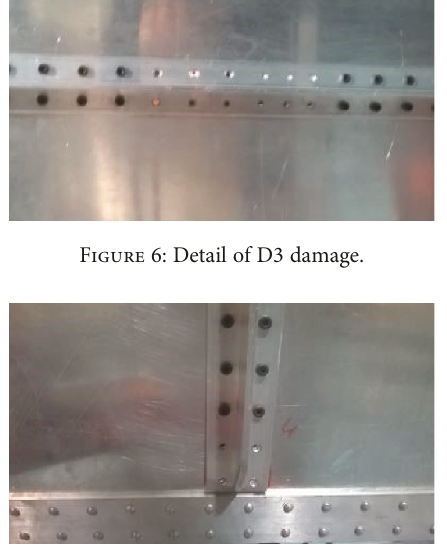
Figure 7: Detail of D5 damage. Table 2: First 20 eigenfrequencies for the undamaged panel and for the three damages with their % variations.